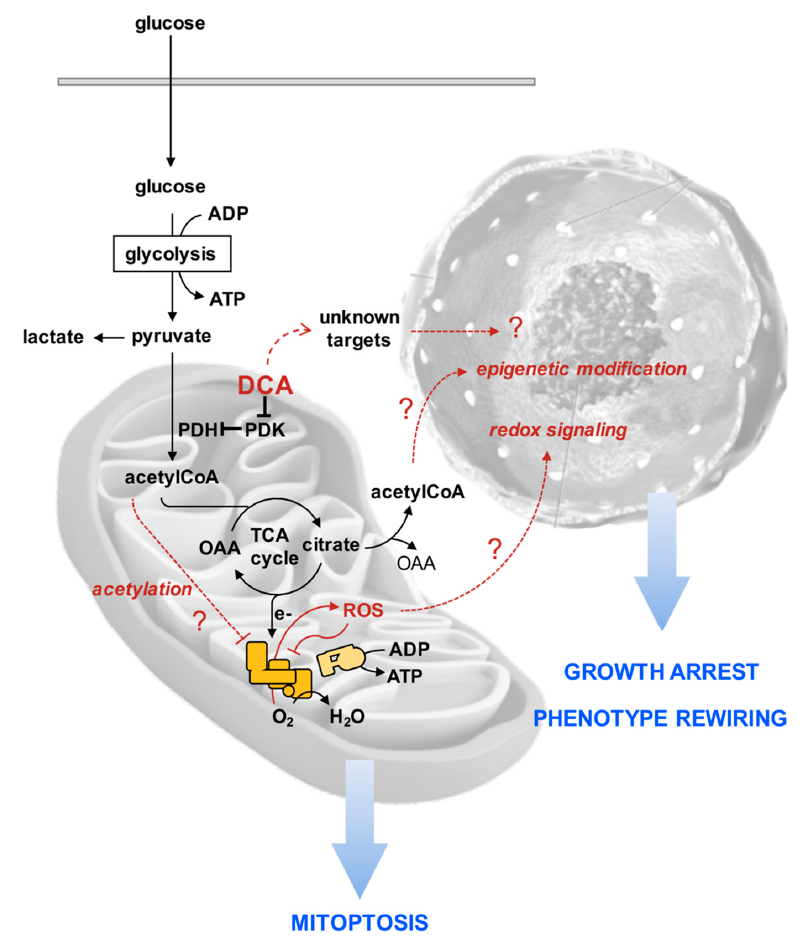
Figure 10. Working model for the e ff ects of DCA described in this study. The pathway of the DCA-mediated mitochondrial oxidation of pyruvate is shown by black arrows. PDK: pyruvate dehydrogenase kinase; PDH: pyruvate dehydrogenase; TCA: tricarboxylic acid; OAA: oxaloacetate. The red lines and the question marks in the mitochondria and nucleus indicate hypothesized e ff ects directly or indirectly linked to the DCA action. See Discussion for further details.